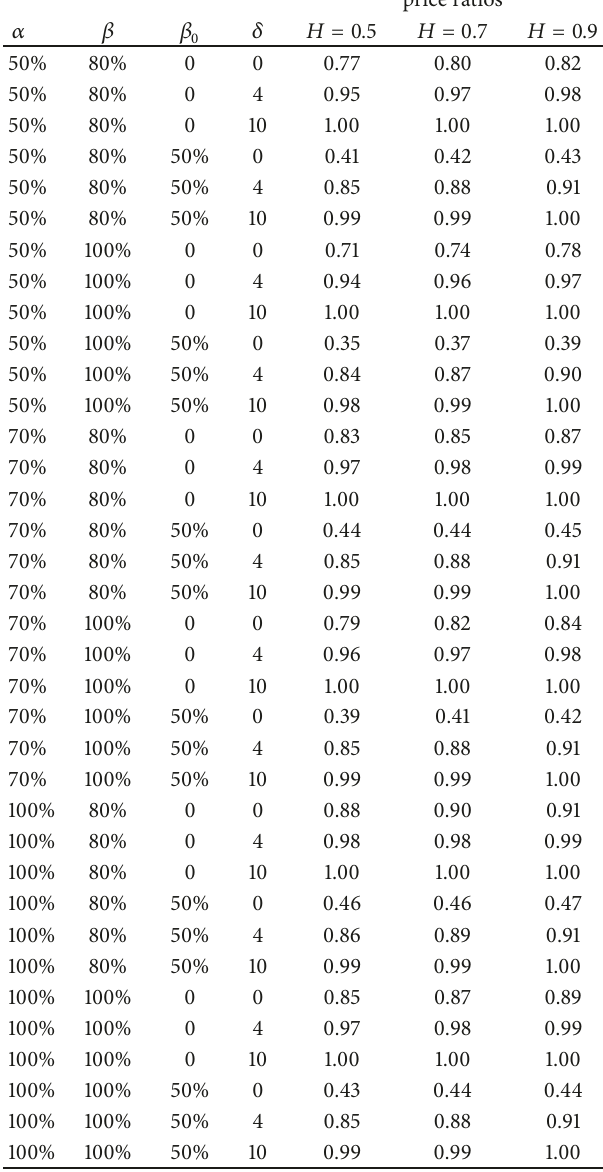
Table 2: Price ratios of exotic option allowing proactive hedging relative to classical European option under constant parameters ( 𝛼,𝛽, 𝛽 0 , 𝛿)